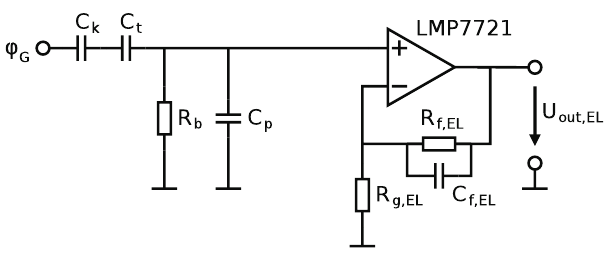
Fig.3: Circuit diagram of the active electrode.